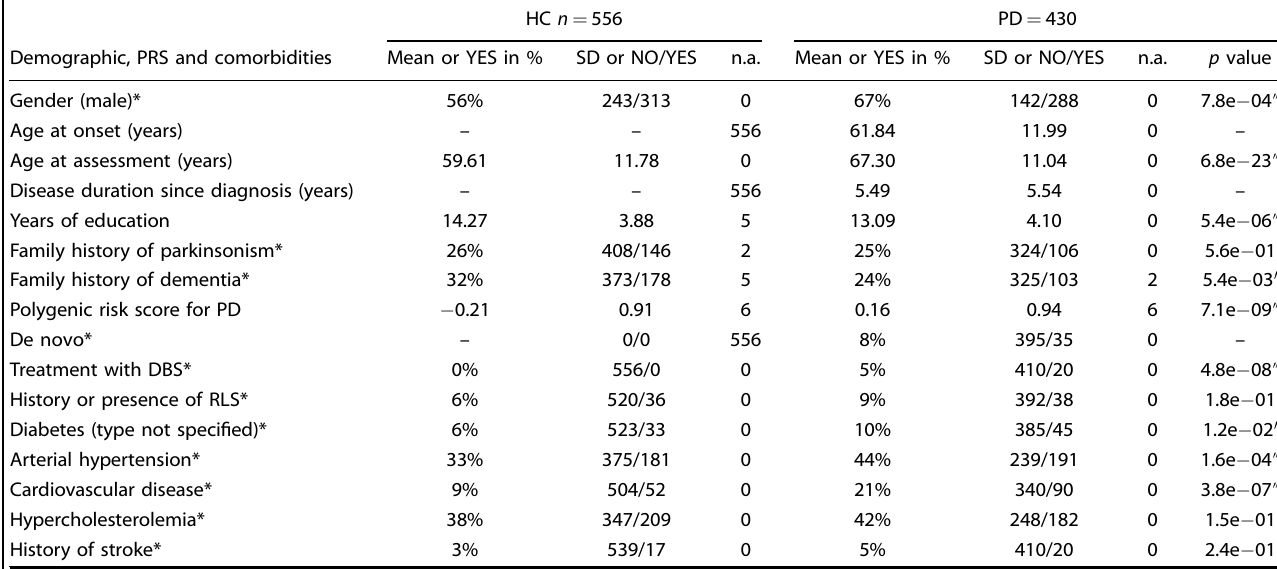
Single and double ticks indicate signi fi cance at the 5% level and the Bonferroni-adjusted 5% level respectively. The binary variables are annotated by asterisk. n.a. corresponds to total number of missing values per variable, PD Parkinson ’ s disease, PRS Polygenic risk score, HC Healthy controls, DBS Deep brain stimulation, SD Standard